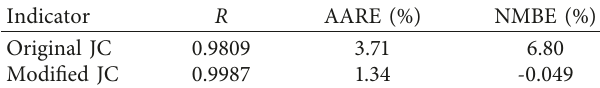
Figure 17: Correlation analysis between experimental values and predicted values: (a) the original JC model and (b) the modified JC model. Table 8: The performance of the two